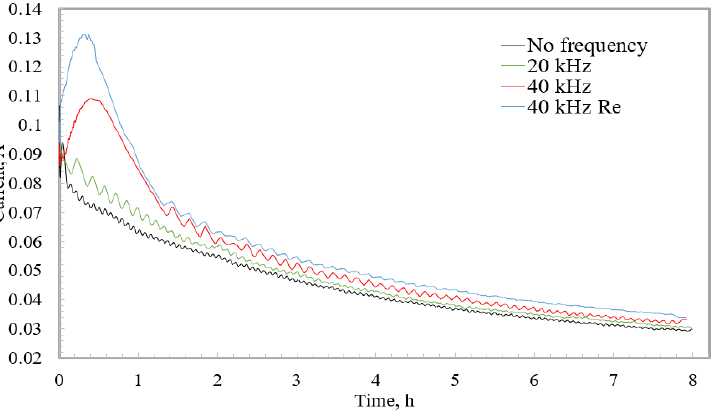
Figure 7. Current–time curves recorded during the second step of the anodization process. In Figure 7, the curves of the current measurement in four different fabrication regimes were presented. The first curve, when anodization was performed without the use of high- frequency excitation, can be named the standard anodization curve. First, the curve was increased, and then the curve steadily decreased, revealing a slowing process. Slight current fluctuations were caused by changing the reactor temperature in the range of 4.5–6.0 ◦